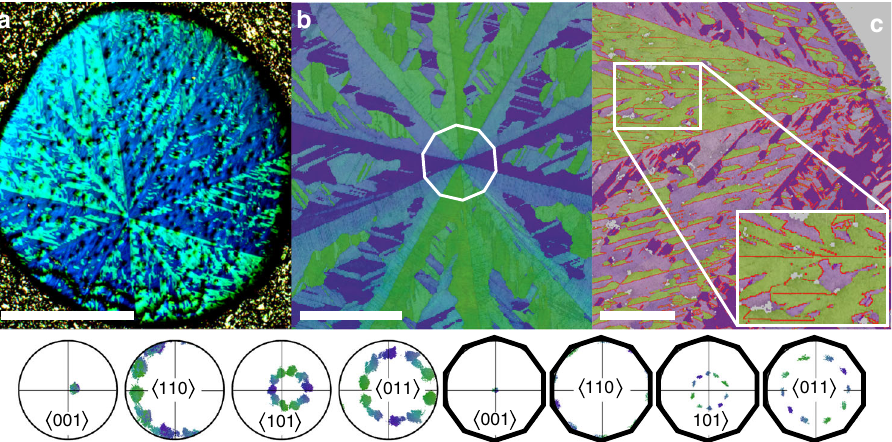
Fig. 2 Tenfold twinned NiZr. Dendritic microstructure of NiZr cross-sections ( a (scale bar 500 μ m): optical polarization micrograph; b (scale bar 100 μ m) and c (scale bar 200 μ m): false-color EBSD-maps) is con fi rmed by a series of IPFs (bottom): A single cluster of crystal orientations aligns with the axial growth direction along a common [001]-axis of the NiZr twin domains, while a perfect tenfold clustering is observed for perpendicular 〈 110 〉 -directions. Circular IPFs represent the crystallographic orientations for the complete EBSD-map of a slightly inclined sample; decagonal, alignment-corrected IPFs highlight perfect orientational relationships for the highlighted central part of the microtwin